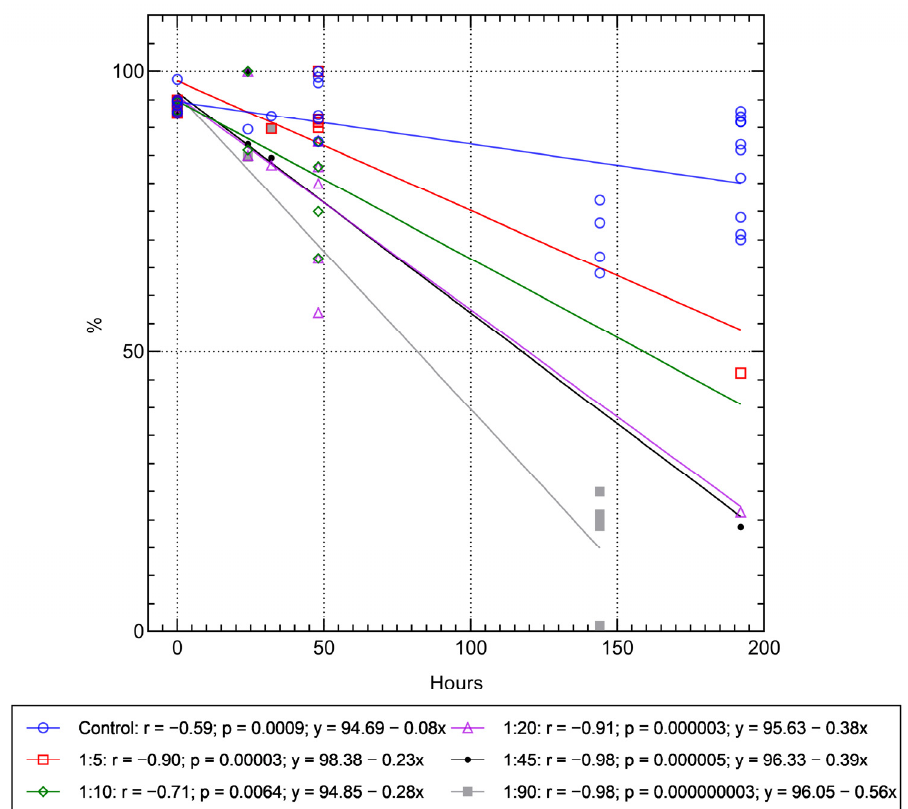
Figure 3. Regression dependences of hAMSC viability on the dose of internalized microcapsules during in vitro post-phagocytosis cultivation.